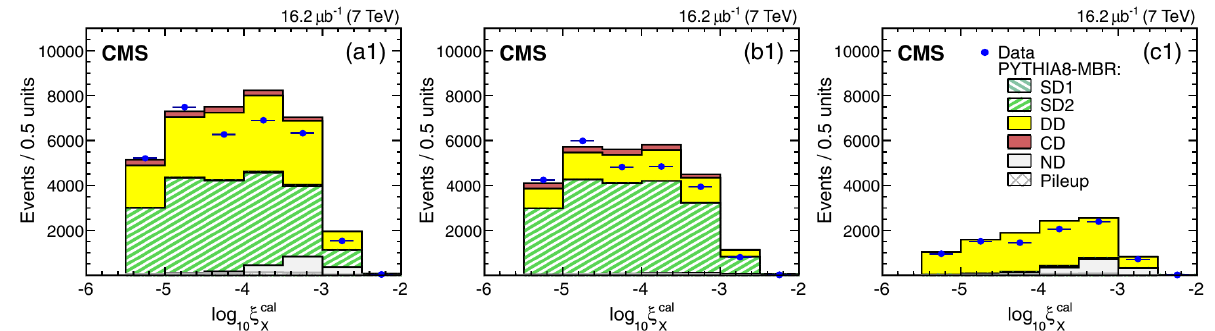
Figure 5. The shapes of the distributions of the number of events as function of the proton rapidity loss as determined by CMS calorimeters ξ cal . In (a1) all events with forward rapidity gap are shown, in (b1) all of those events with no signal in CASTOR, and in x (c1) those events that were flagged by CASTOR. See Ref. [6]. Figure 1. Measurement of the photon-proton cross section as function of photon energy (from Ref. [2]). This result is part of the exclusive Υ measurement by CMS in proton-lead collisions Figure 3. The fraction of colour singlet exchange in events with at √ s NN = 5 . 02TeV. two jets, see Ref. [4], as function of the jet-separation ∆ η jj .